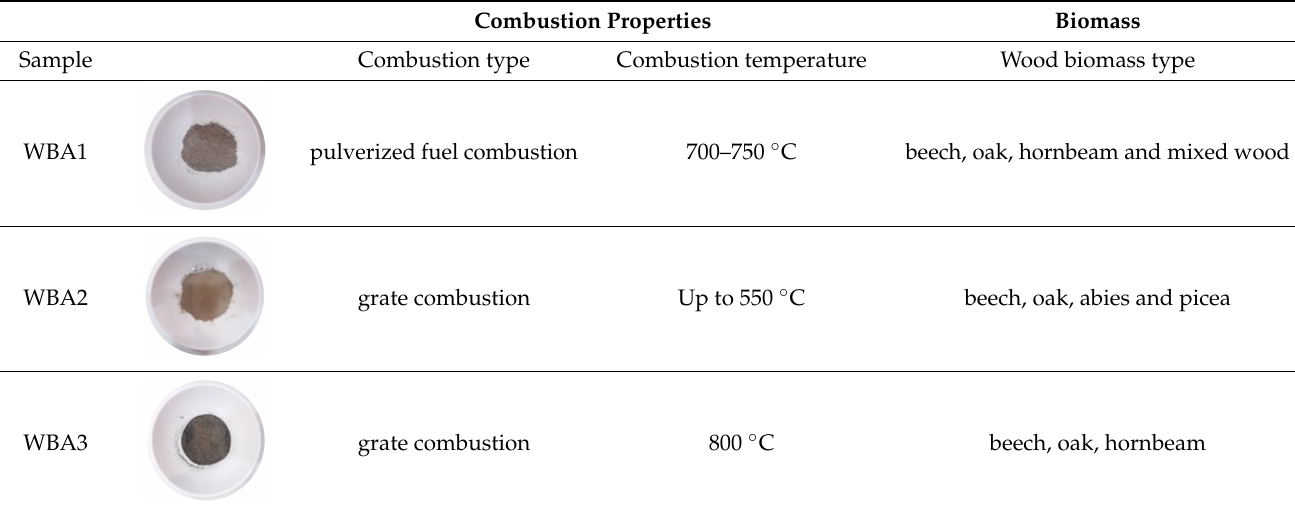
Table 2. Characteristics of power plants where fly WBAs was collected. Combustion